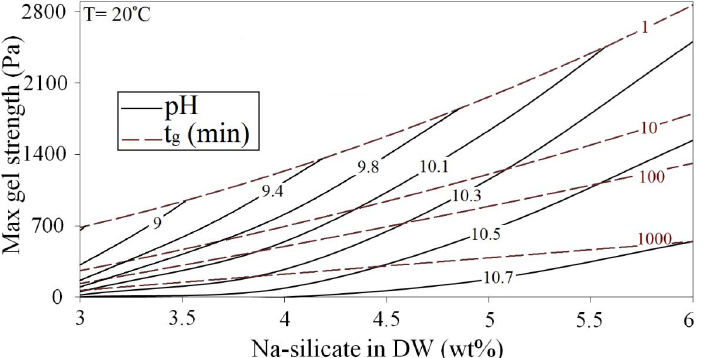
The effect of temperature on the gel strength for 4.5 wt% Na-silicate with a pH of 10.30